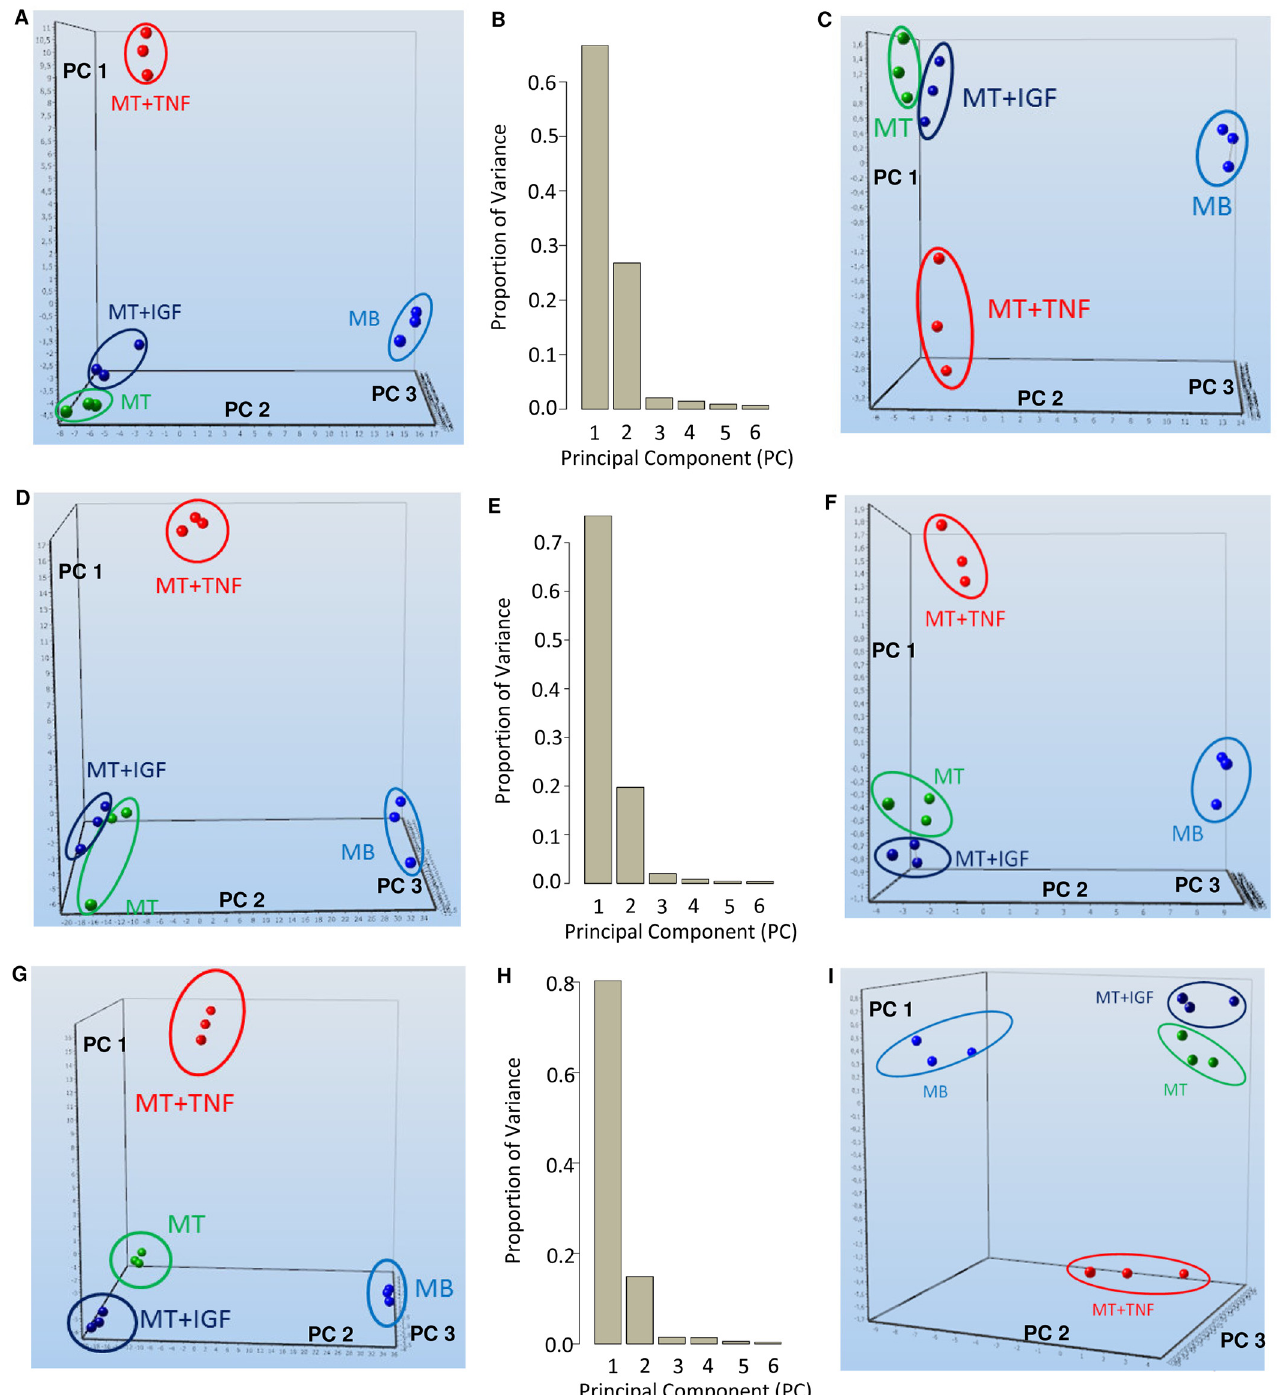
Fig 2. Transcriptomic signatures of myoblast differentiation and TNF- α or IGF1 treatment. Principal component analyses (PCA) of mRNA expression profiling data after (A) 4 h, (D) 12 h, or (G) 24 h of induction of differentiation with TNF- α , IGF1, or control treatment showing nonambiguous genes are depicted. Axes show principal components (PC) 1, PC 2, and PC 3. PCA revealed separation of treatment groups. Light blue indicates myoblasts, green marks myotubes, red distinguishes myotubes treated with TNF- α , whereas dark blue indicates myotubes treated with IGF1. The proportions of variance for the first six components of principal component analysis are depicted for the effect of (B) 4 h, (E) 12 h, and (H) 24 h after induction of differentiation and the respective treatments. Most of the variance is described by PC 1 followed by PC 2 and PC 3. PC 1 explaines most of the variance of myocyte differentiation while PC 2 represented most of the variance induced by TNF- α whereas PC 3 characterized most of the variance caused by IGF1 treatment. Moreover,